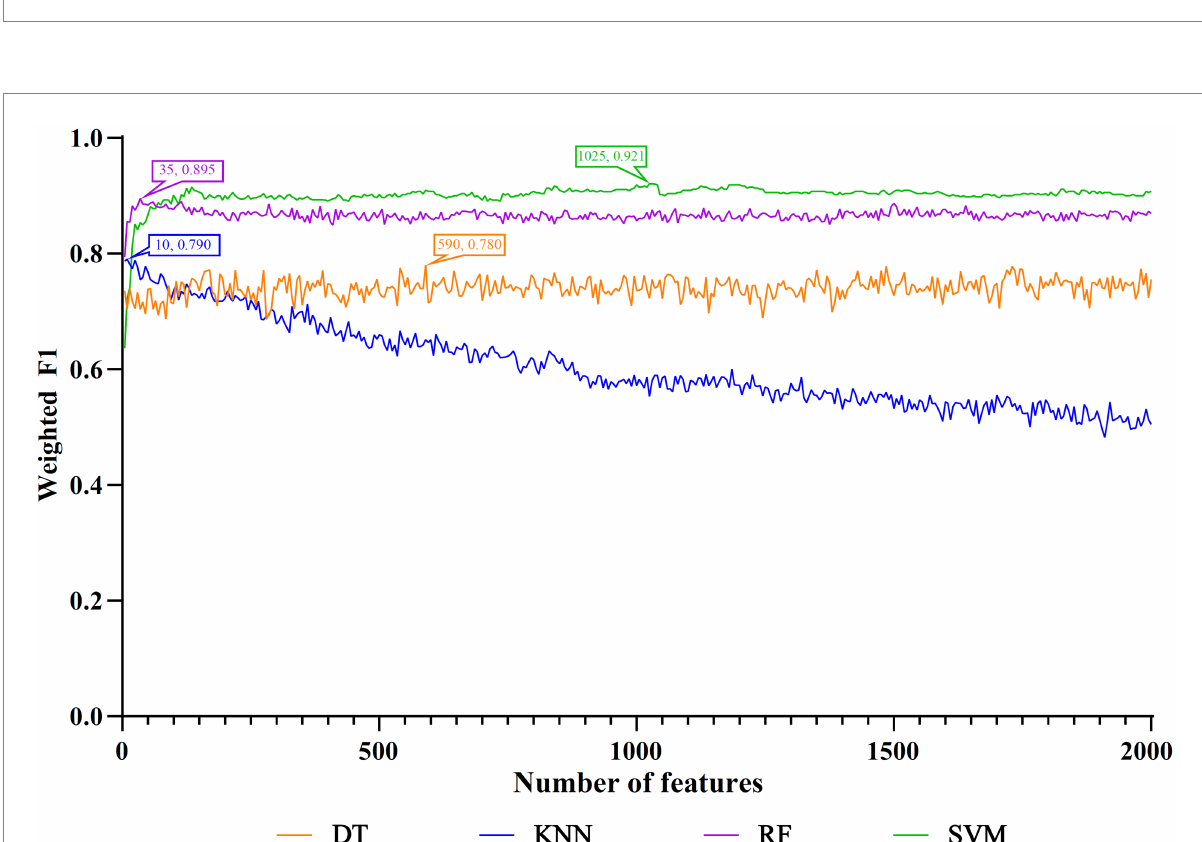
FIGURE 3 IFS curves to show the performance of different classification algorithms under different feature subsets. The highest weighted F1 for each classification algorithm was marked on the corresponding IFS curve. The SVM yielded the highest weighted F1 of 0.921 when top 1,025 features were used.